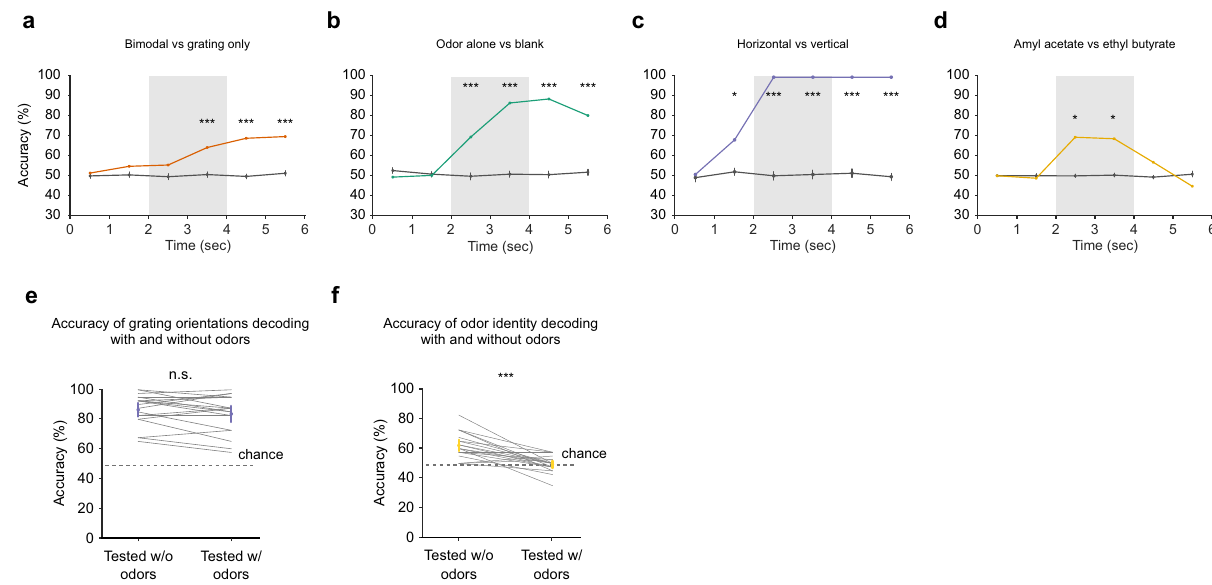
Fig. 6 Tactile and olfactory codes are independent in wS1. a Accuracy of centroid classi fi ers decoding bimodal from touch-only stimuli based on S1 activity in the passive context averaged over 1-s time bins. Performance for shuf fl ed labels is shown in gray. Error bars indicate 95% con fi dence intervals for the mean. P values were obtained as the location of the mean accuracy in a distribution of 1000 shuf fl es (two-sided, no correction for multiple testing); * P < 0.05, ** P < 0.01, *** P < 0.001. Shading indicates stimulus presentation. b – d Same as in a for decoding of odor only and blank stimuli, grating orientation, and odor identity, respectively. e Accuracy of centroid classi fi ers trained to decode grating orientations without odors and showing no impairment when tested in the presence of odors (mean without odors = 88.5% (83.4, 93.1); mean with odors = 86.3% (81.0, 91.0); P = 0.401; Wilcoxon signed-rank test). f Same as in e for decoding odor identity with classi fi ers trained without touch and going to chance level when tested with touch (mean without touch 63.9 = % (60.6, 67.1); mean with touch = 49.2% (46.4, 51.9); P = 2.62 × 10 − 8 ; Wilcoxon signed-rank test). All tests are